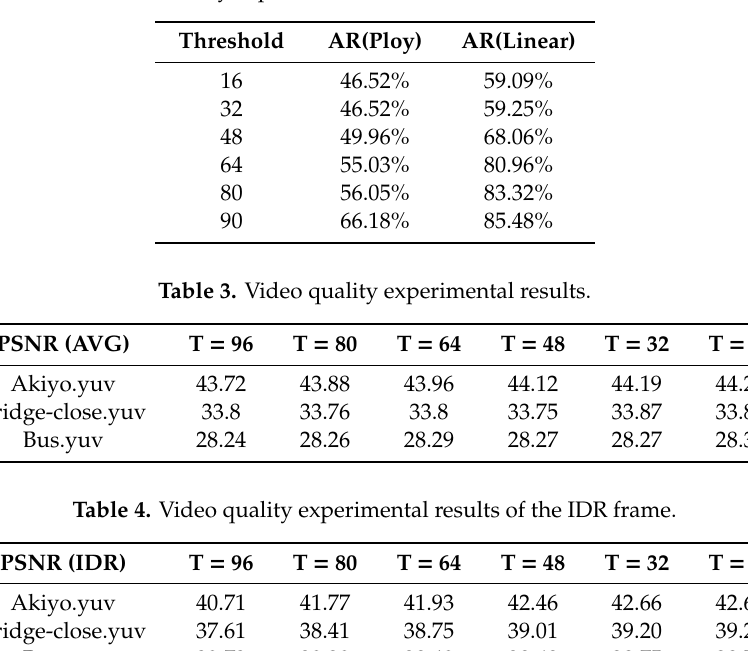
Table 2. Security experiment results of the di ff erent thresholds.